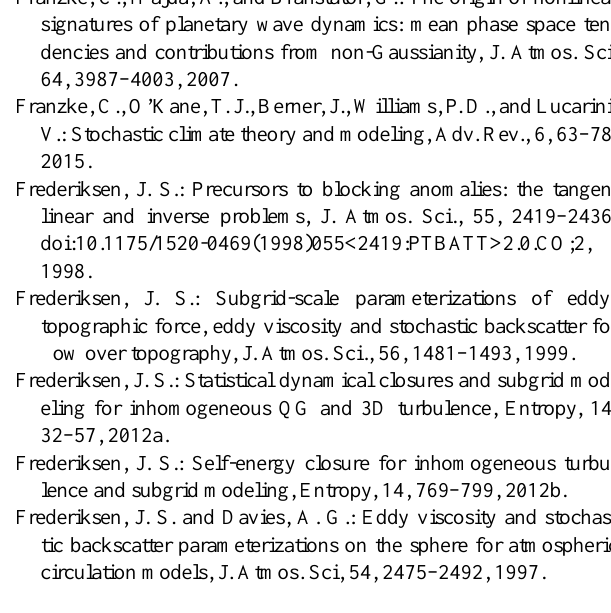
pared to LES with T R = 252 in Fig. 5b. Again all LES